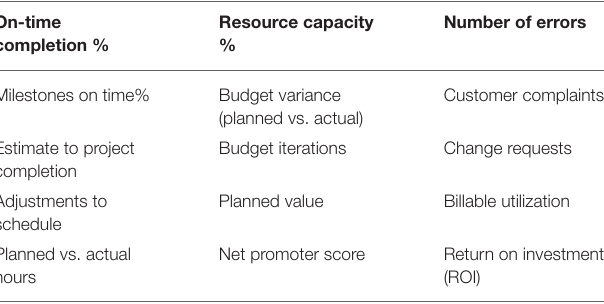
TABLE 1 | KPIs for autonomous tool for monitoring multi-morbidity health conditions in UAE and India. On-time completion